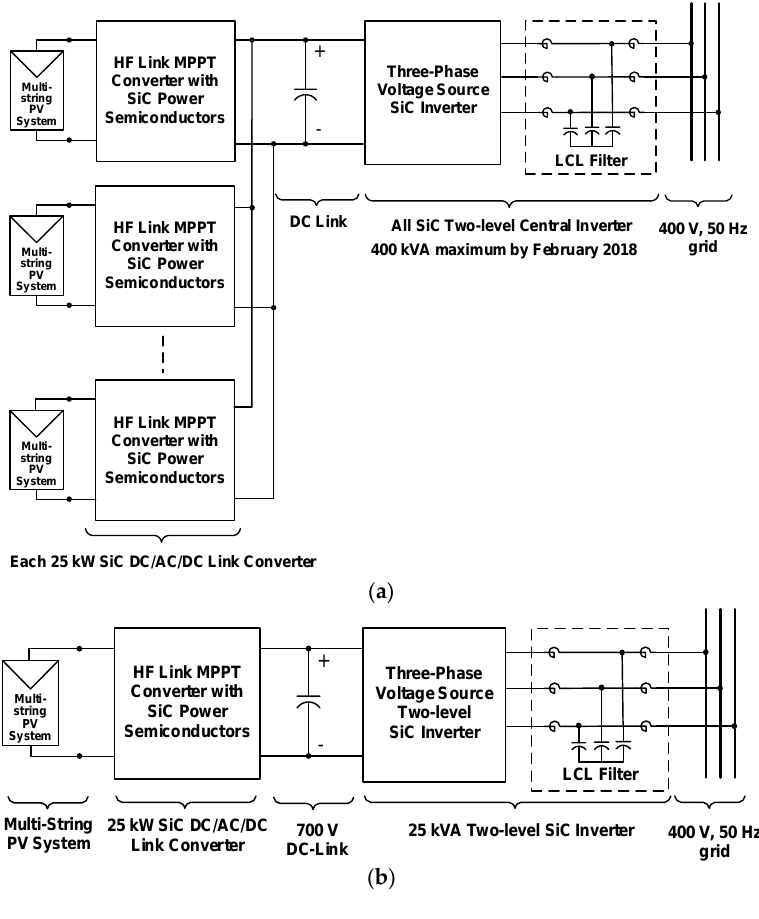
Figure 1. All SiC three-phase grid-connected PV supply with high-frequency link: ( a ) Multi-string PV inverter system; and ( b ) Experimental set-up.